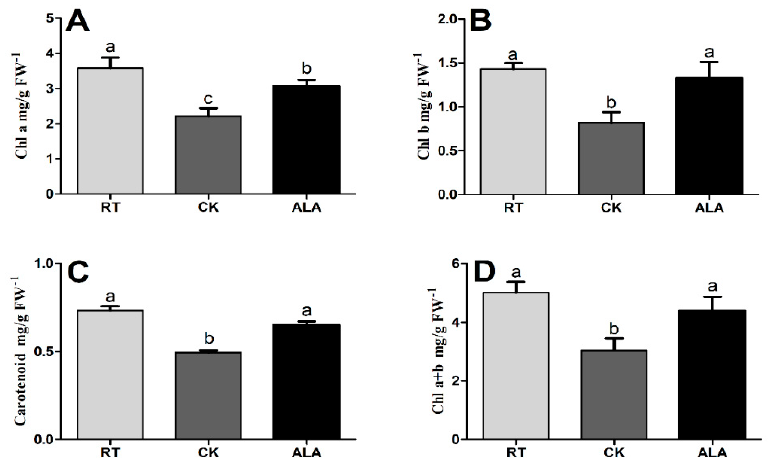
Figure 1. The effect of ALA on chlorophyll ( A : Chlorophyll A (Chl a); B : Chlorophyll b (Chl b); C : Carotenoid; and D : Chlorophyll a+b (Chl a+b)) accumulation under low-temperature stress conditions. RT = regular temperature, CK = control; ALA = 30 mg/L ALA. Treatments indicated by the same letters are not significantly different at p < 0.05.